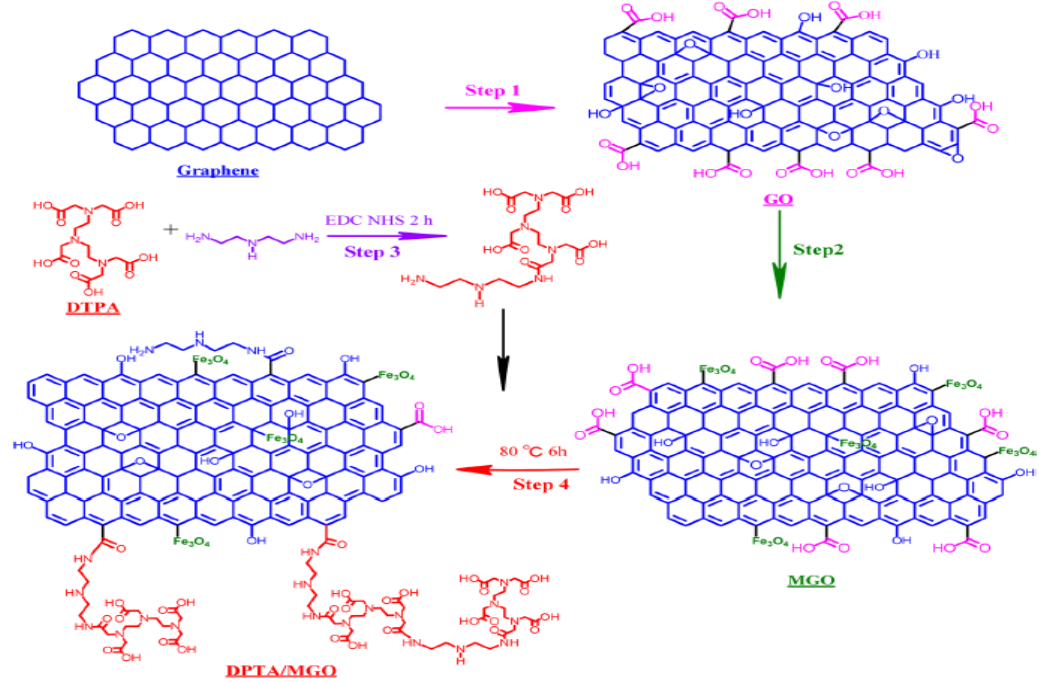
Figure 10. Synthesis Processes and Chemical Structure of DTPA / MGO (Reproduced or adapted from ref. [39], with permission from American Chemical Society, 2020).